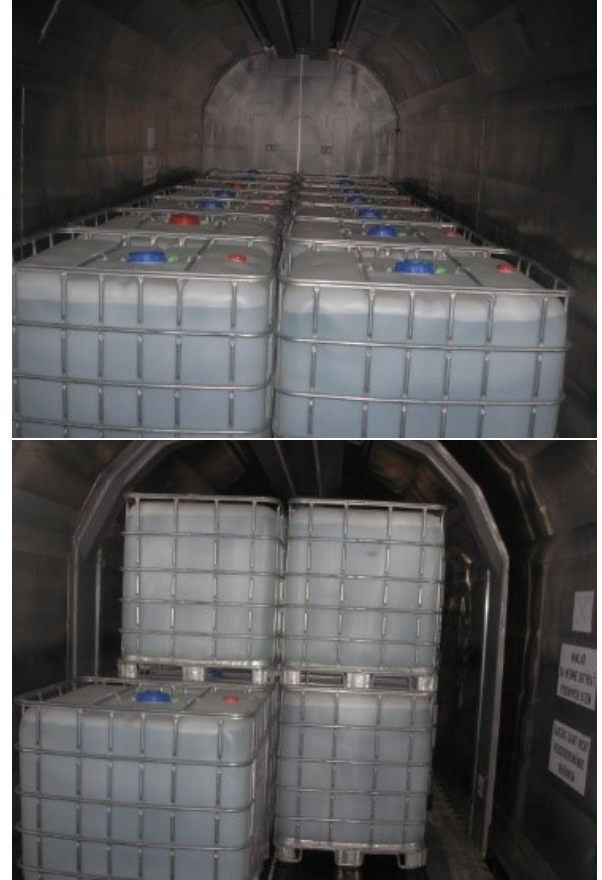
Figure 3: Loading of IBC containers into the railway wagons